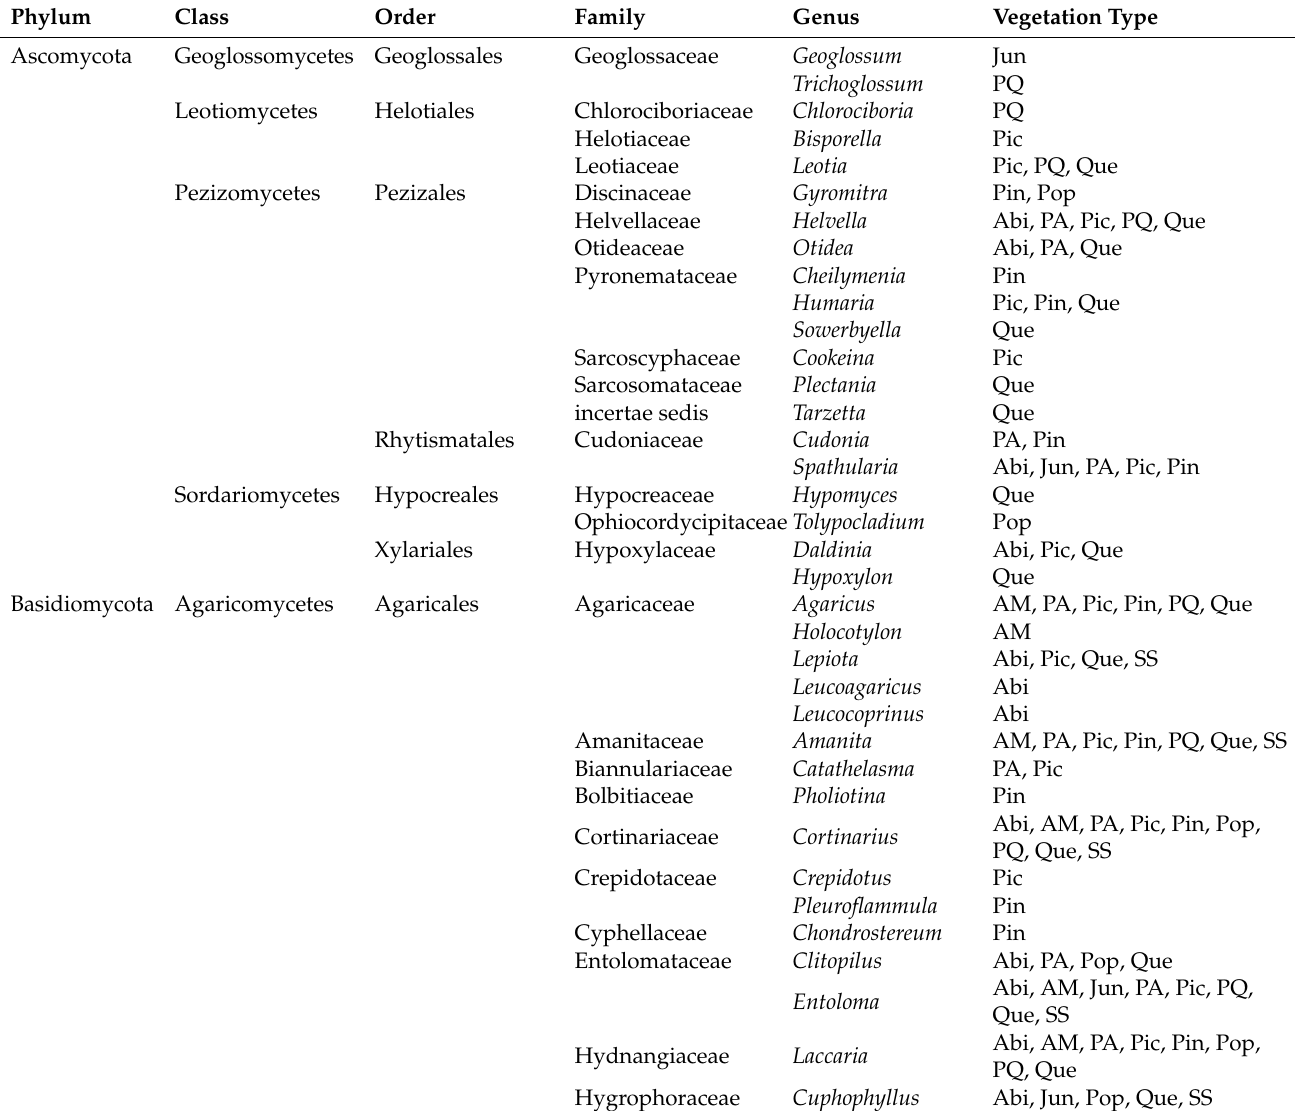
Table 1. Composition of the macrofungal flora in different vegetation